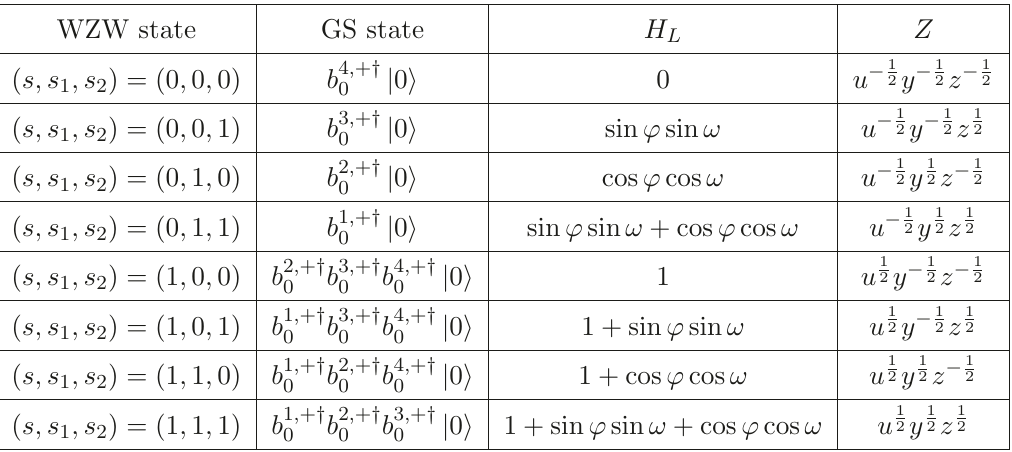
Table 2 . Low-lying states in the R sector. In the left column we describe the states in terms of the fermionic zero-modes in the WZW language. In the second column, we describe them in term of GS fermionic oscillators; note that R sector states correspond to an odd number of GS fermions. In the remaining two columns we write the contribution to the (holomorphic) Hamiltonian and to the partition function that is described